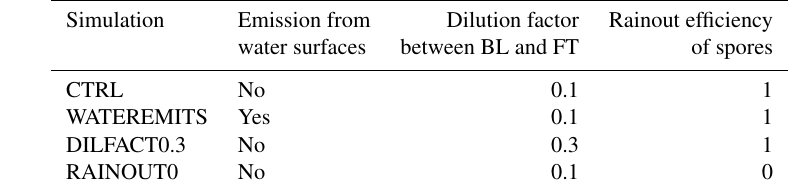
Table 3. Overview of the GEOS-Chem simulations.